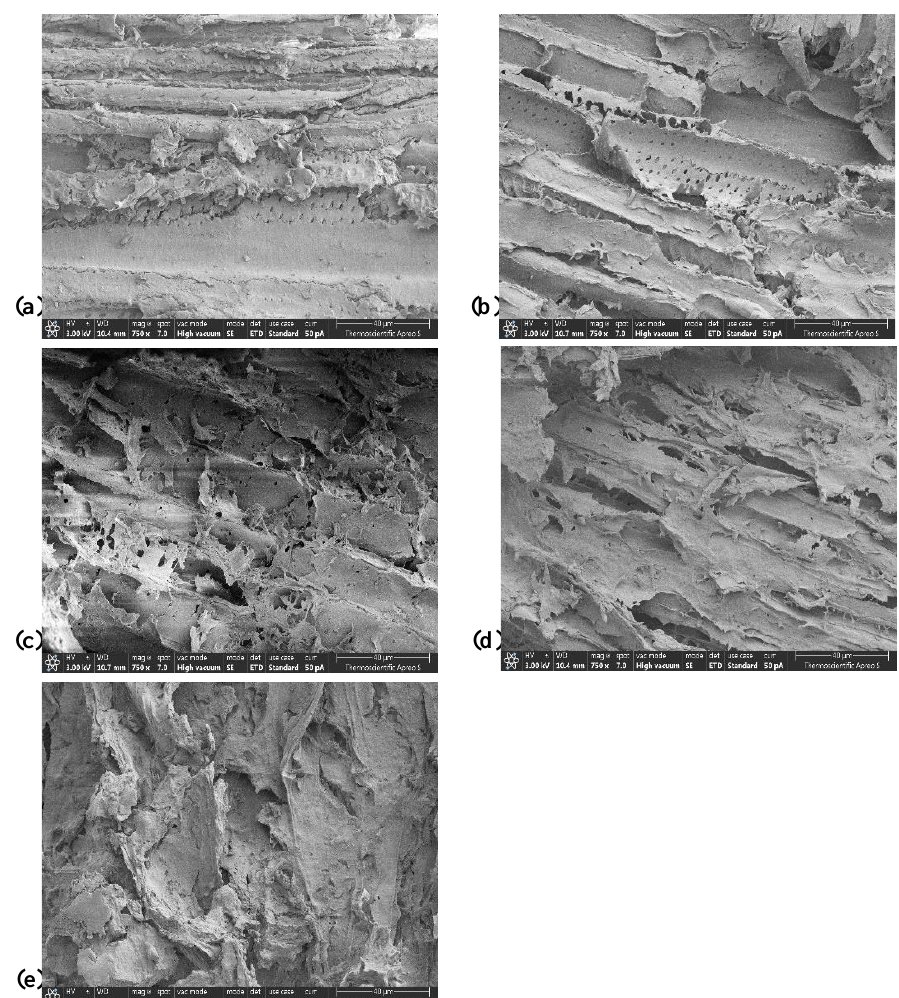
Figure 5. Scanning electron micrographs of core fiber pretreatment with various concentrations of PA; ( a ) Untreated core fiber, and that treated with ( b ) 70% PA, ( c ) 75% PA, ( d ) 80% PA, and ( e ) 85% PA.